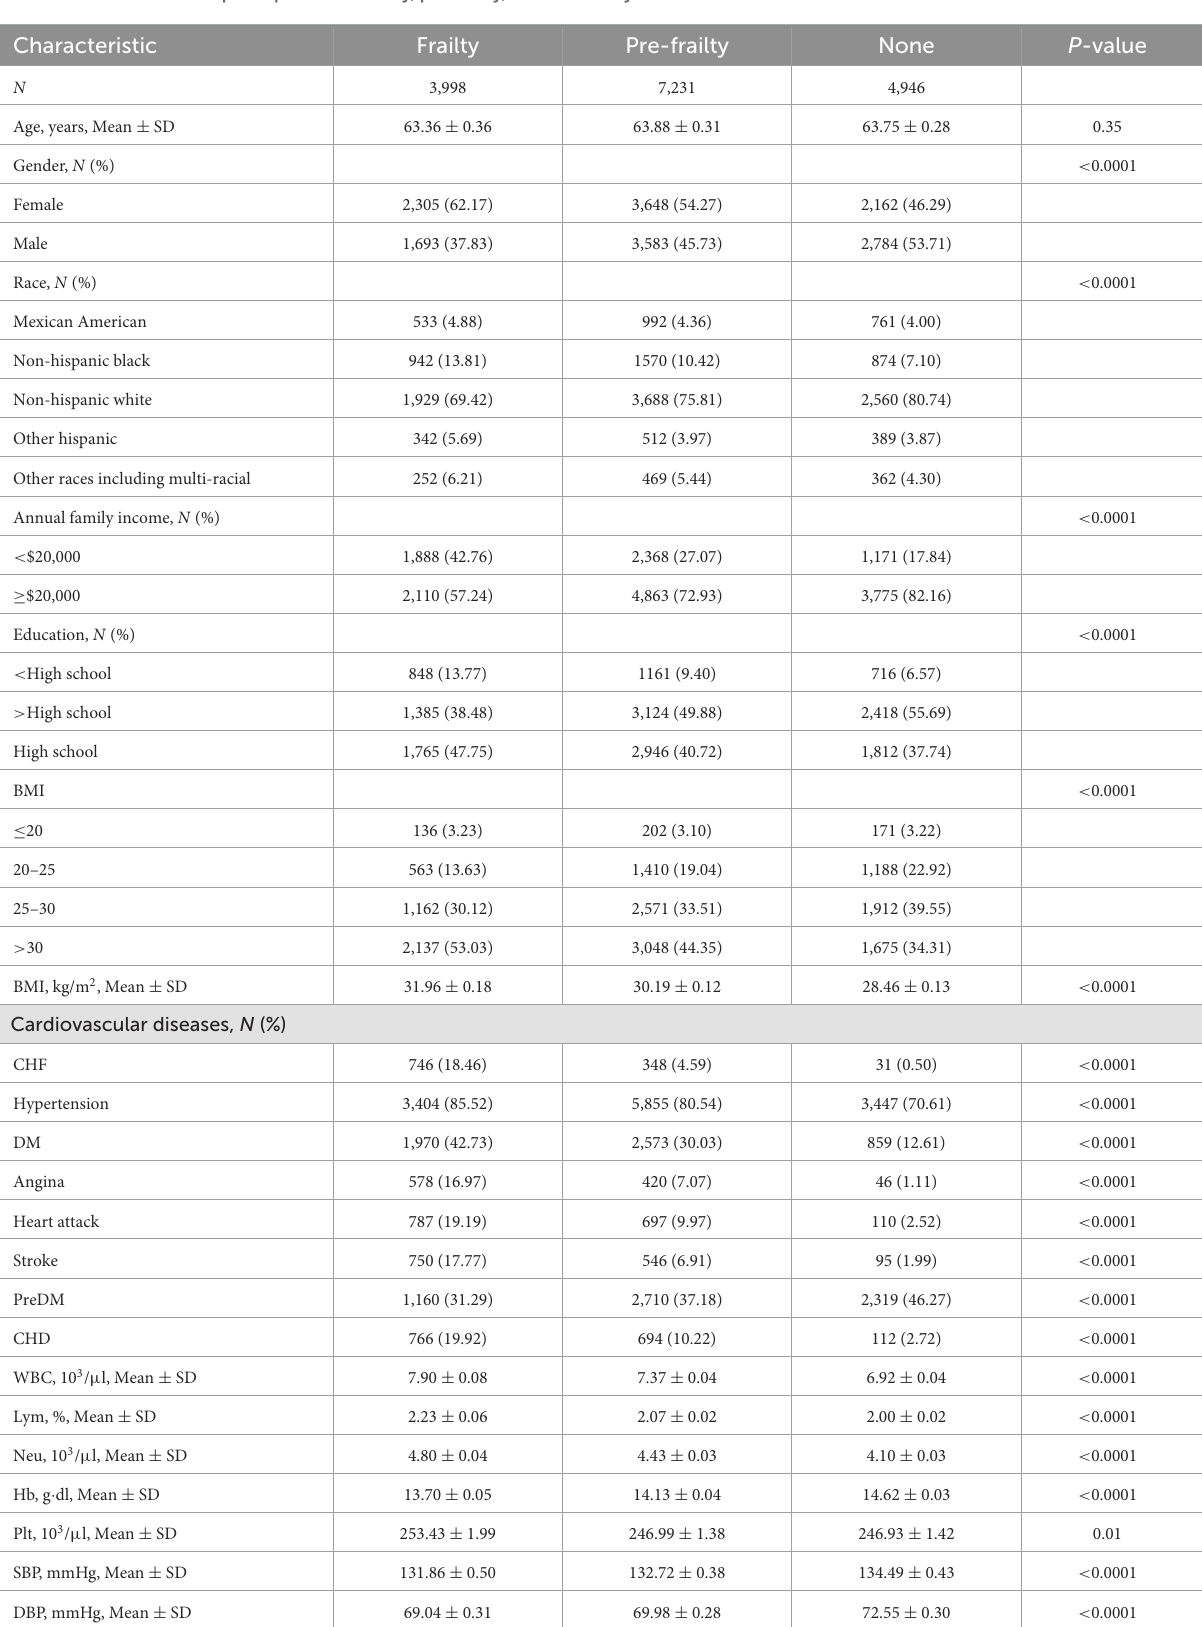
TABLE 2 Characteristics of participants with frailty, pre-frailty, and non-frailty. Characteristic Frailty Pre-frailty None P